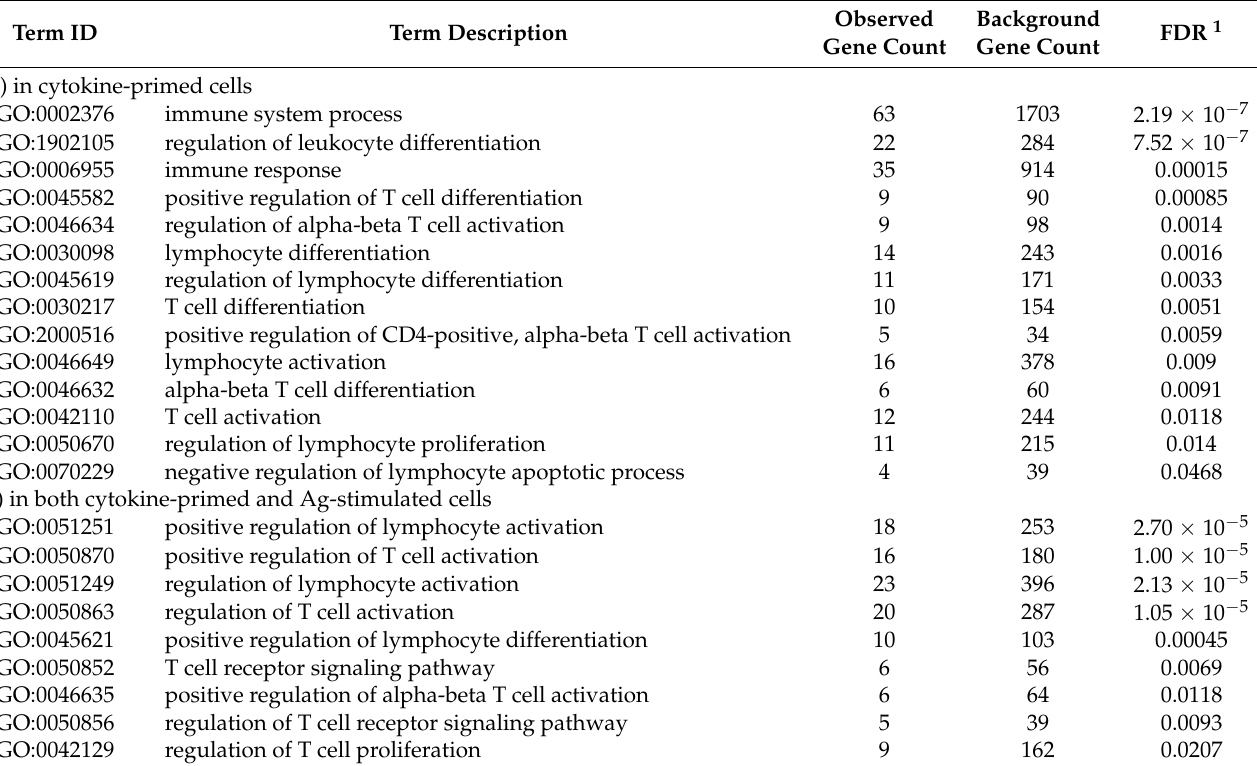
Table 1. GO analysis of genes related to T lymphocyte activation and functions that show changes in chromosome accessibility peaks.